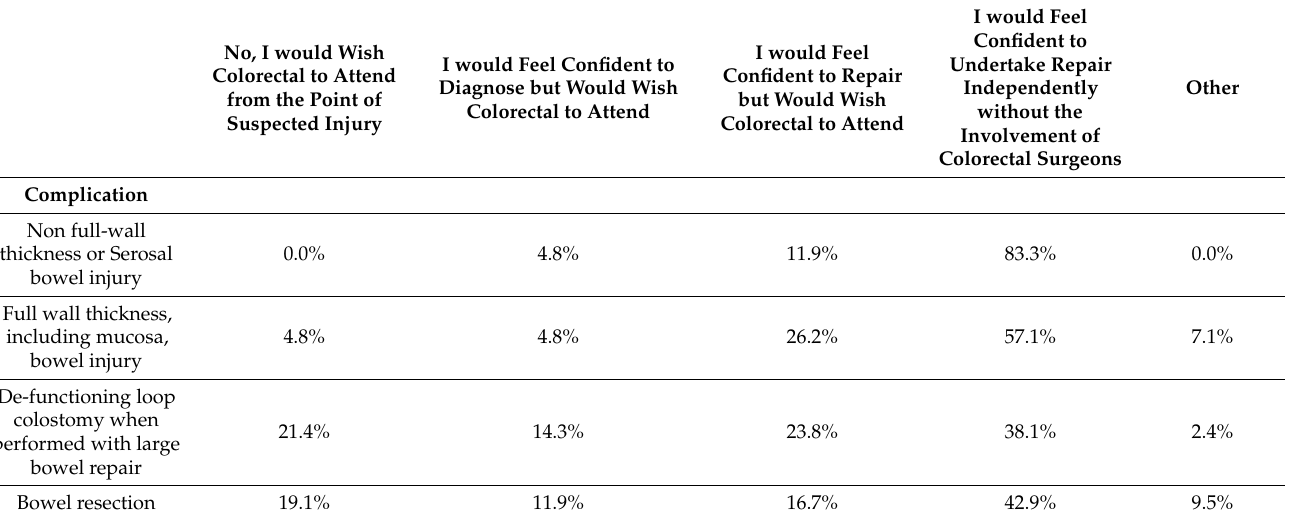
Table 2. Would you undertake or diagnose the following intraoperative